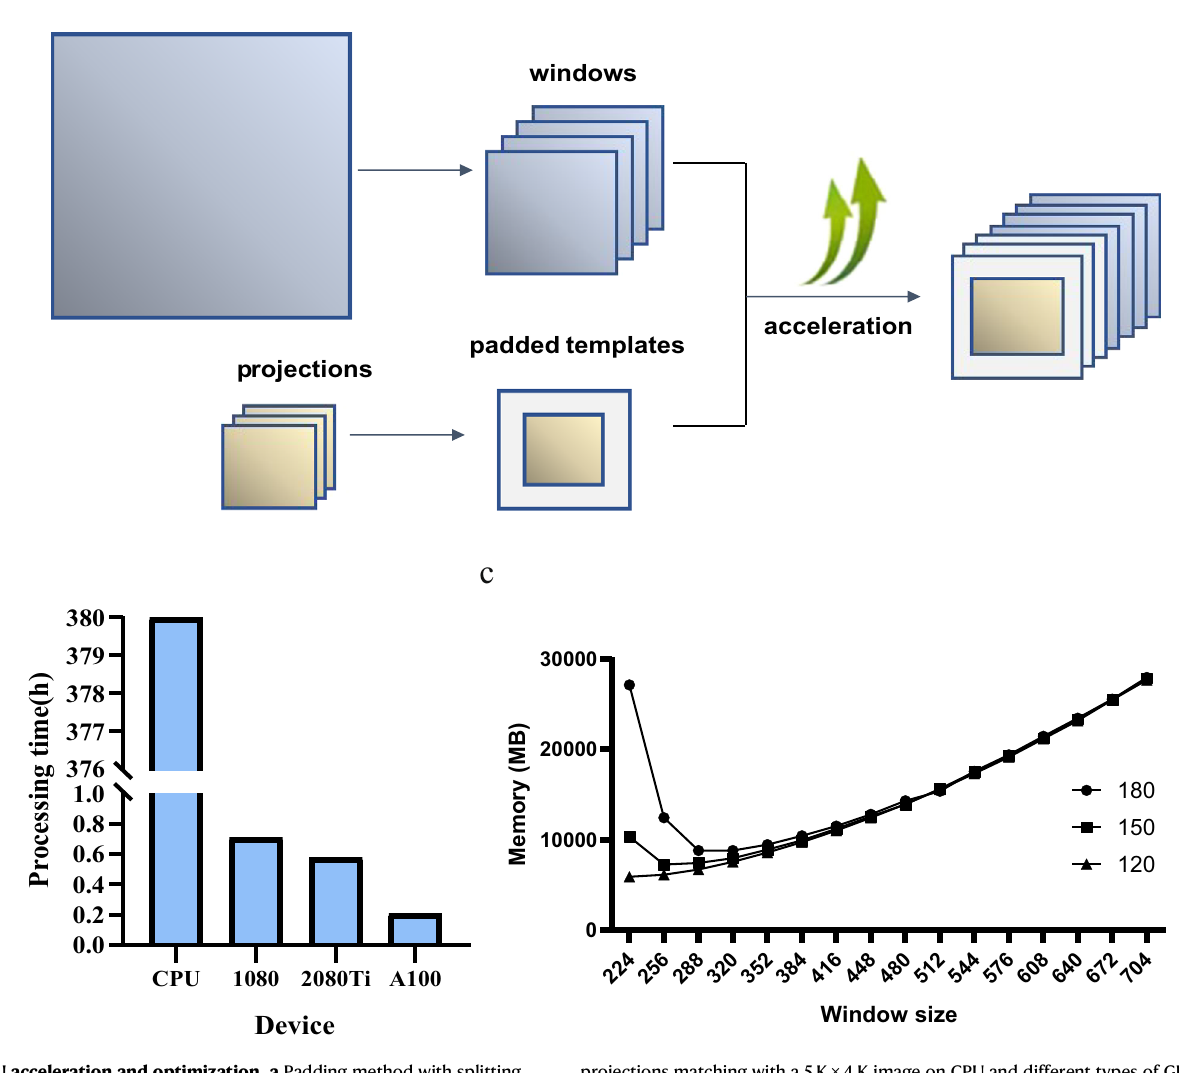
projections matching with a 5K×4K image on CPU and different types of GPUs. c Occupied memory with different window sizes and overlap settings (180, 150, and